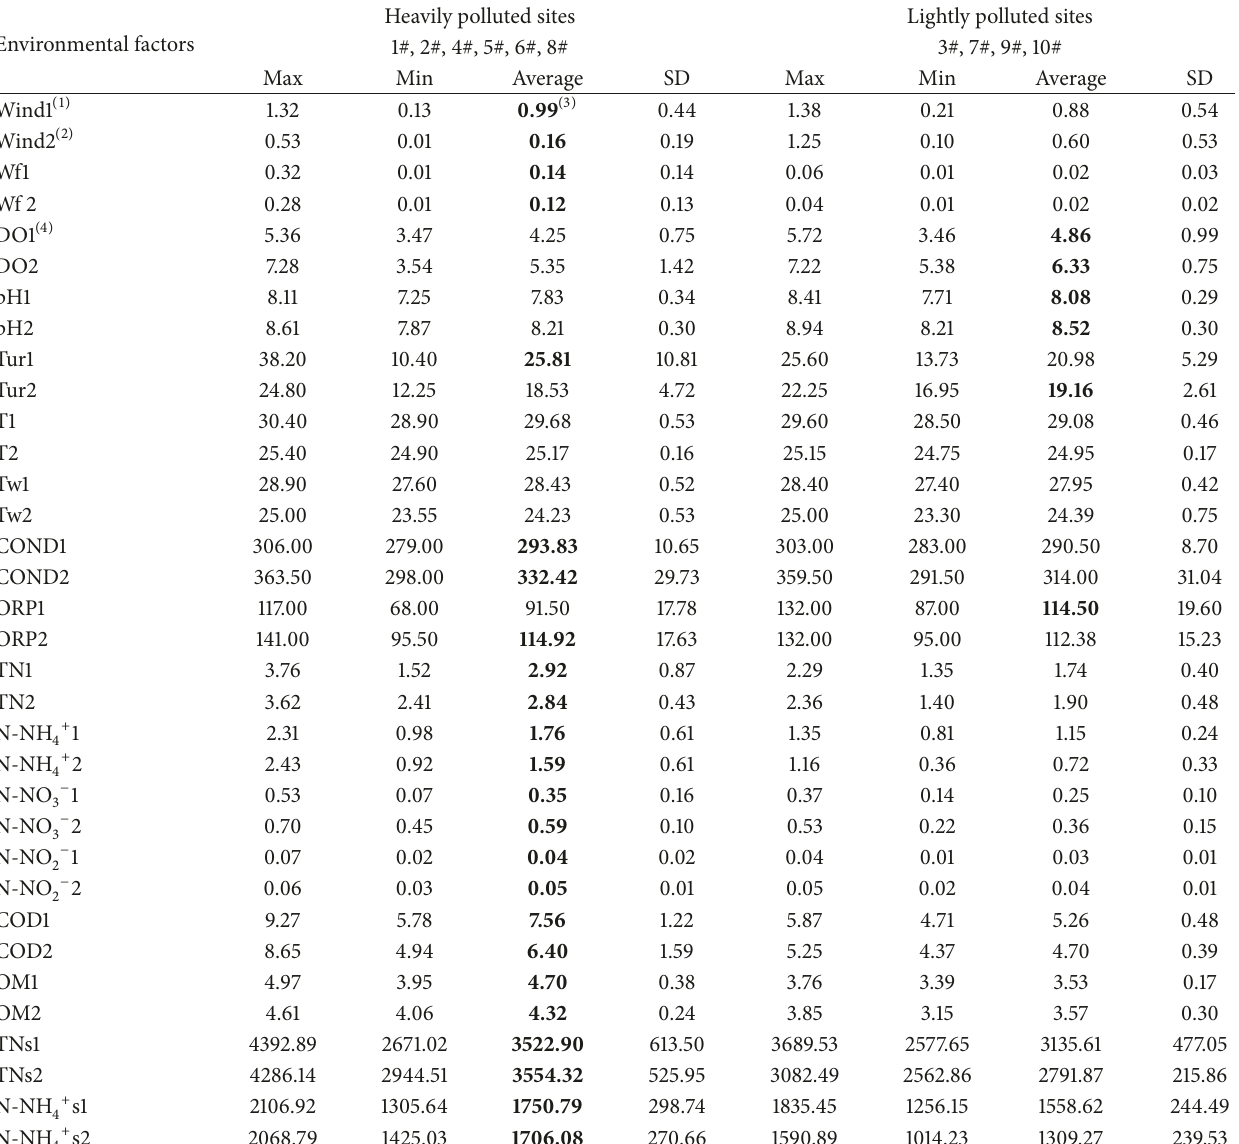
Table 2: The characteristics of environmental factors in water, air, and